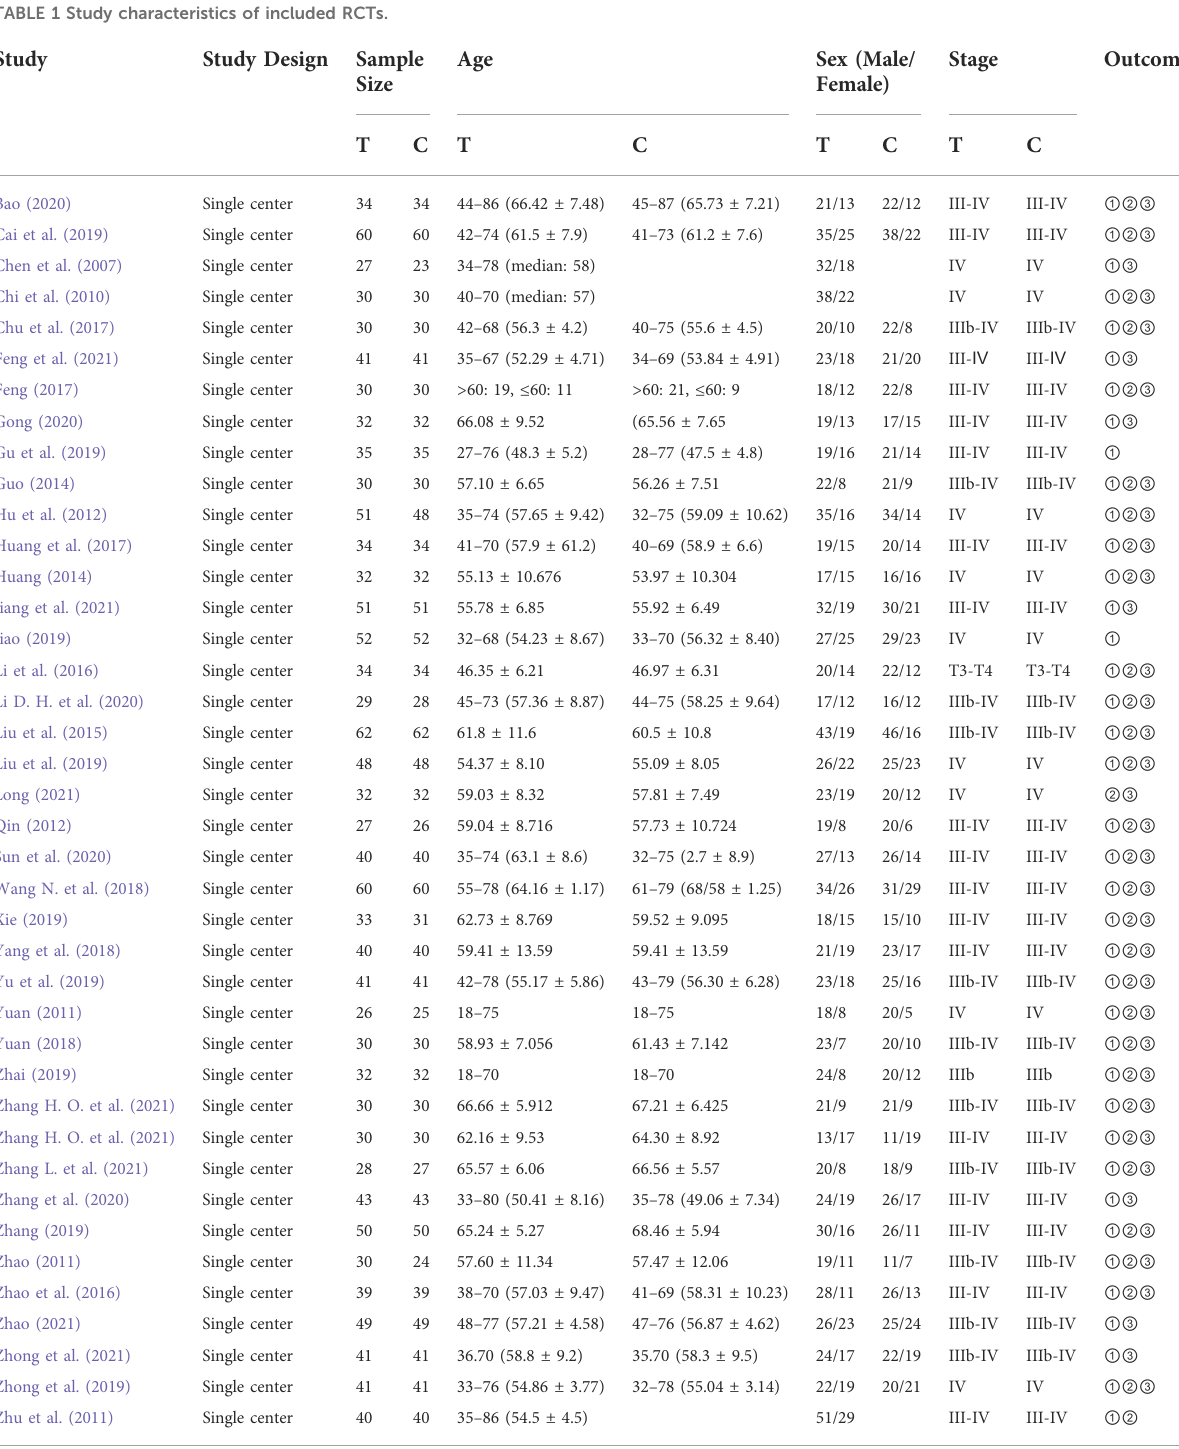
TABLE 1 Study characteristics of included